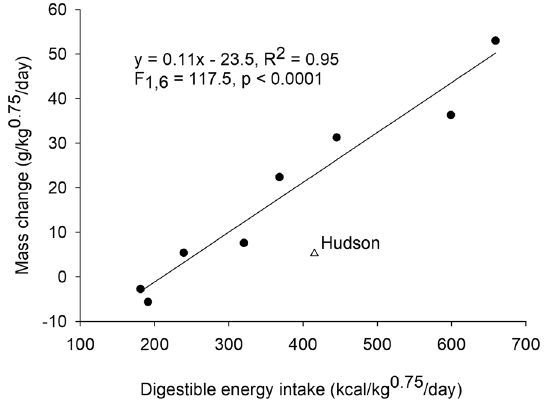
Figure 1. Relationship between digestible energy intake and mass change of 9 polar bears fed ad libitum lean meat and lard. Energy intake and mass change is presented relative to body mass scaled to metabolic rate (i.e., kg 0.75 ). An adult male (Hudson) at the Brookfield Zoo was reported to have paced extensively during the trial while isolated from an adult female and was not included in the regression.